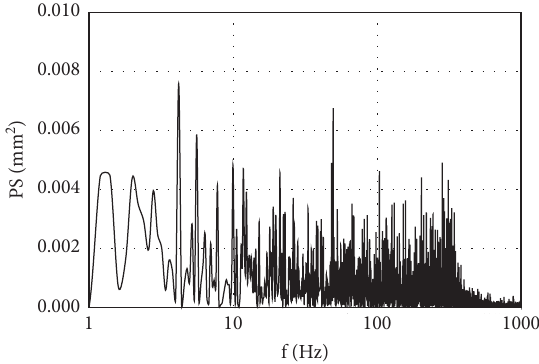
Figure 8: Power spectrum of shock oscillations for laminar interaction.